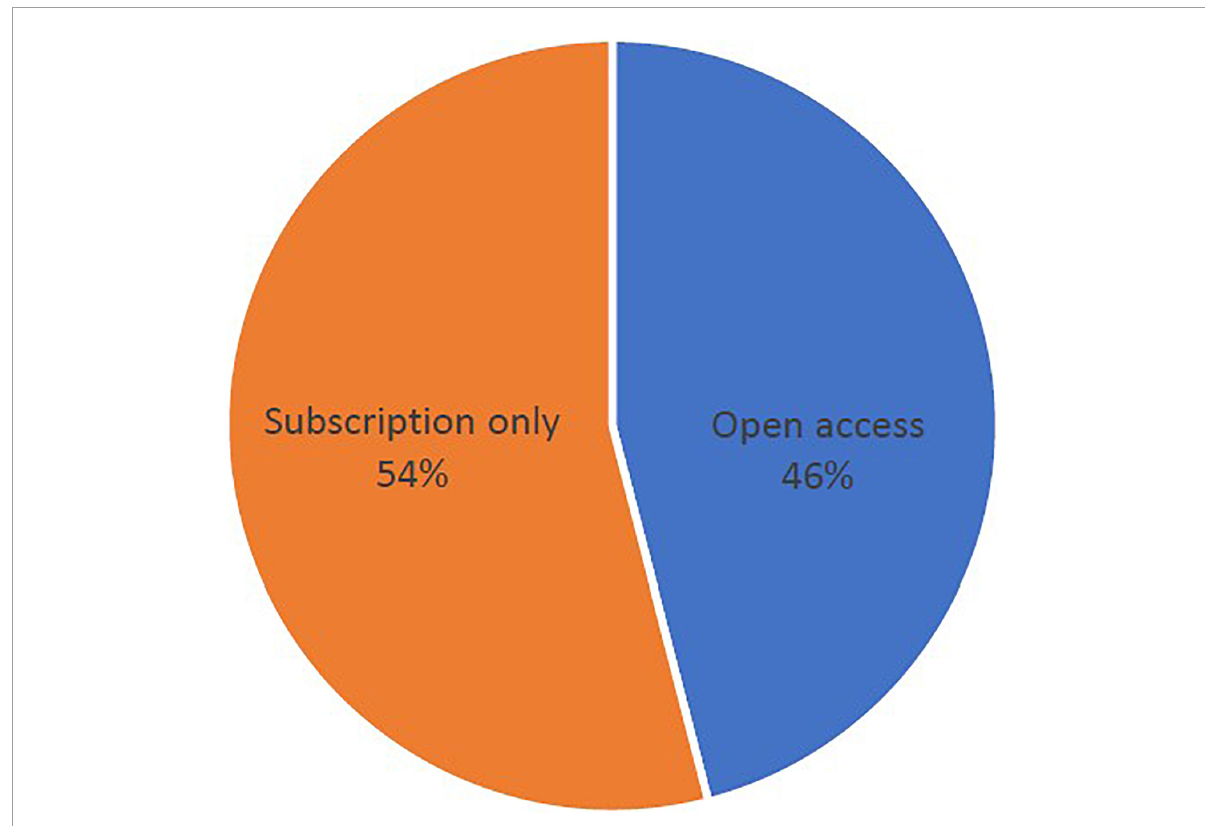
FIGURE2 Open access status of the top 100 most-cited studies of pemphigoid